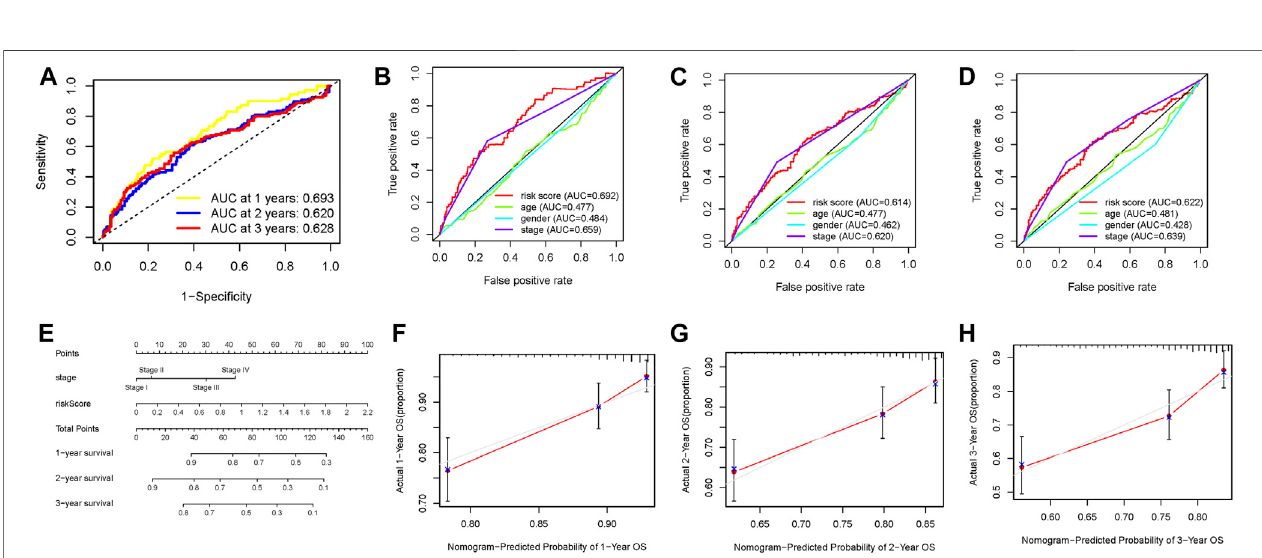
FIGURE 5 | Validation of prognostic ef fi ciency of the DNA methylation – based signature in HCC. (A) ROC curve analysis was employed to estimate the prediction value of the prognostic signature. (B – D) Areas under curves (AUCs) of the risk scores for predicting one-, two-, and three-year overall survival time with other clinical characteristics. (E) Nomogram was assembled by stage and risk signature for predicting the survival of HCC patients. (F) One-year nomogram calibration curves. (G) Two-year nomogram calibration curves. (H) Three-year nomogram calibration curves.